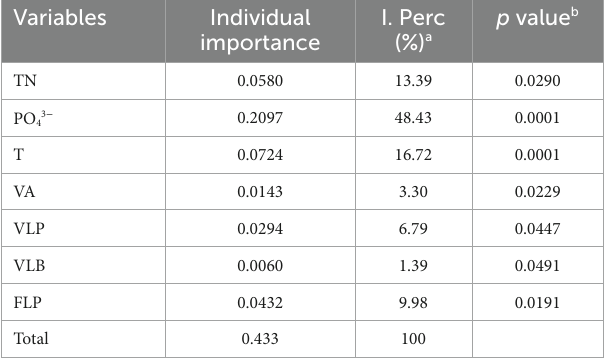
TABLE 2 Percentage and significance of the seven selected explanatory variables to the summer phytoplankton community composition change.